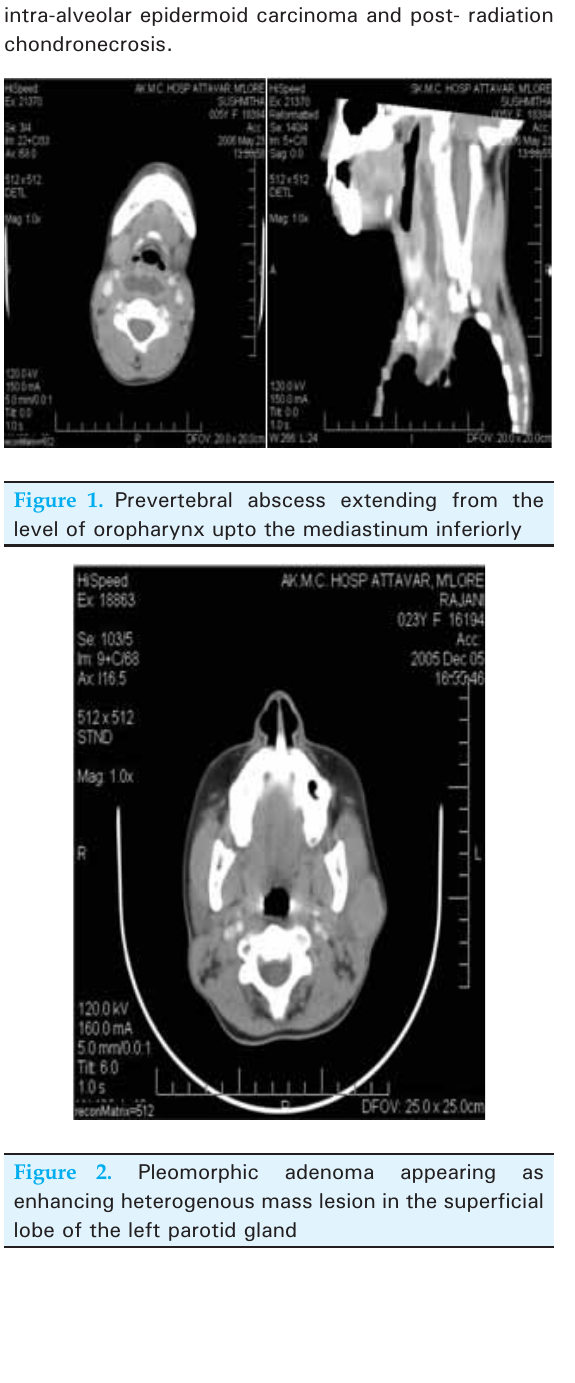
Figure 2. Pleomorphic adenoma appearing as enhancing heterogenous mass lesion in the super(cid:2) cial lobe of the left parotid gland